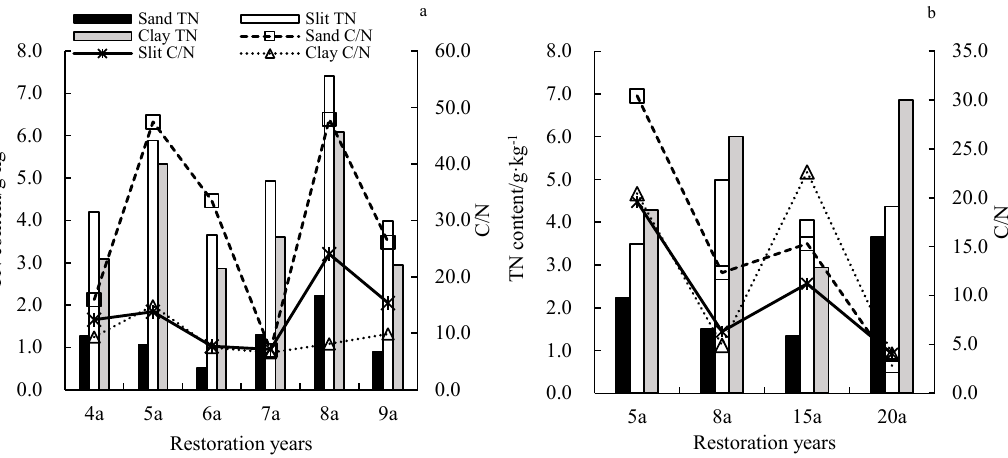
Figure 7. Total nitrogen content and C/N ratios of different soil components in grasslands ( a ) and wood-lands ( b ).